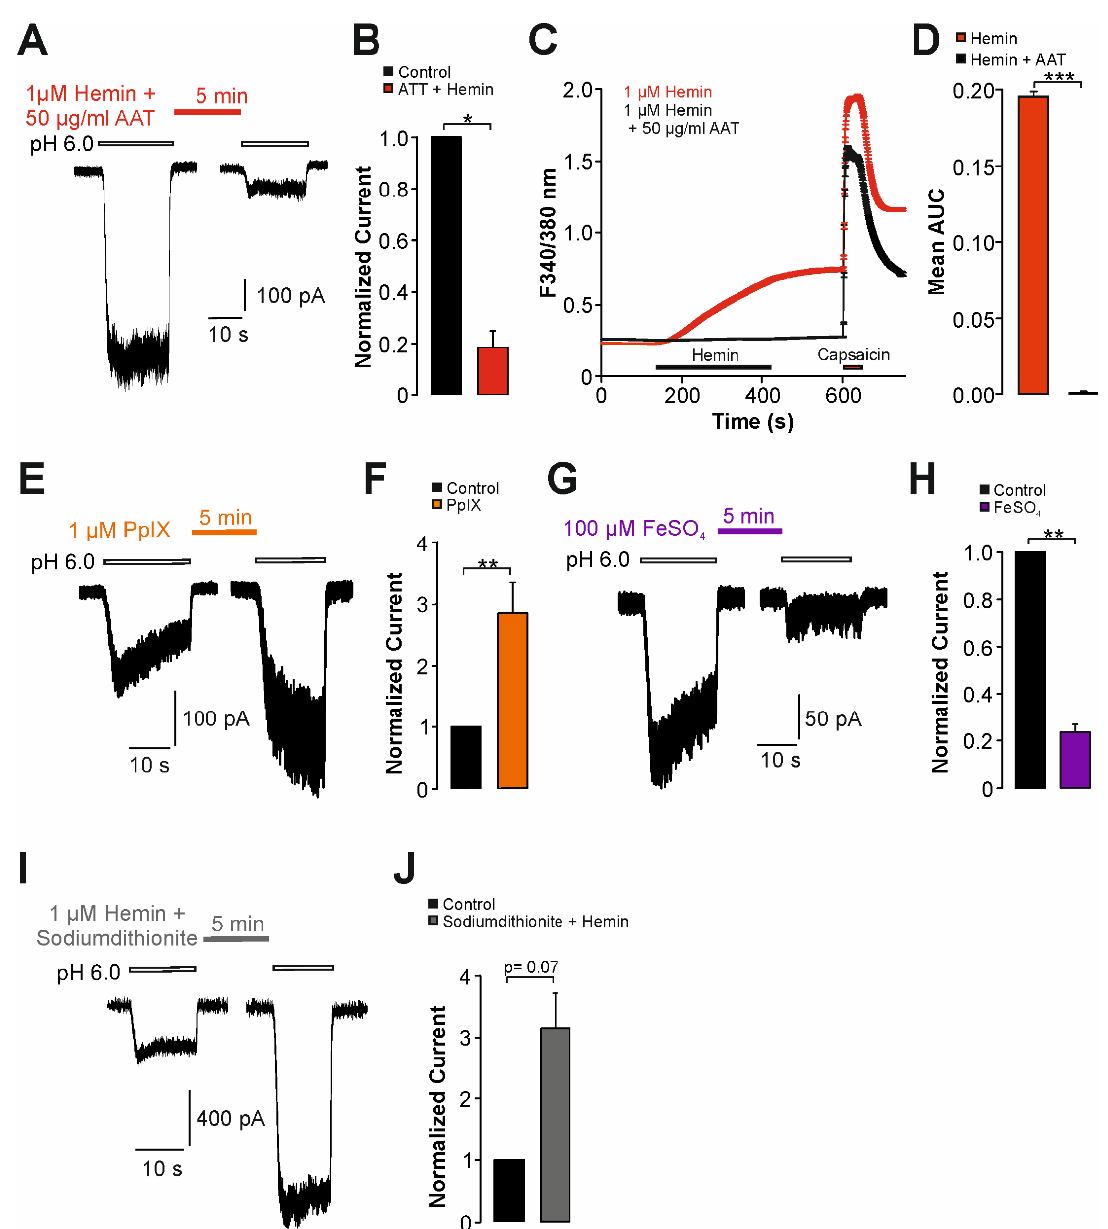
Figure 4. Determinants of hemin-induced activation of hTRPV1. ( A ) Patch clamp recordings on hTRPV1-expressing cells challenged with two consecutive applications of pH 6.0 with 1 µM hemin and 50 µg/mL α 1-antitrypsin (AAT) applied for 5 min between applications of protons. ( B ) Mean normalized peak amplitudes of inward currents evoked by pH 6.0 in ( A ). Current amplitudes were normalized to the first current. ( C ) Hemin-induced (1 µM) calcium responses in hTRPV1-ex- pressing cells applied with or without application of 50 µg/ml AAT. ( D ) Area under the curve (AUC) for hemin-induced increase in fluorescence ratio described in ( C ). ANOVA F(5,3787) = 196.42, p < 0.001. ( E,G,I ) Patch clamp recordings on hTRPV1-expressing cells challenged with two consecutive applications of pH 6.0 with 1 µM PpIX ( E ), 100 µM FeSO4 ( G ), or hemin and 10 µM sodiumdithionite ( I ) applied for 5 min between applications of protons. ( F,H,J ) Mean normalized peak amplitudes of inward currents evoked by pH 6.0 in ( E,G,I ), respectively. Current amplitudes were normalized to the first current. Cells were held at − 60 mV in all patch clamp experiments. Data are shown as mean ± S.E.M. * denotes p< 0.05, ** denotes p< 0.01, *** denotes p< 0.001.